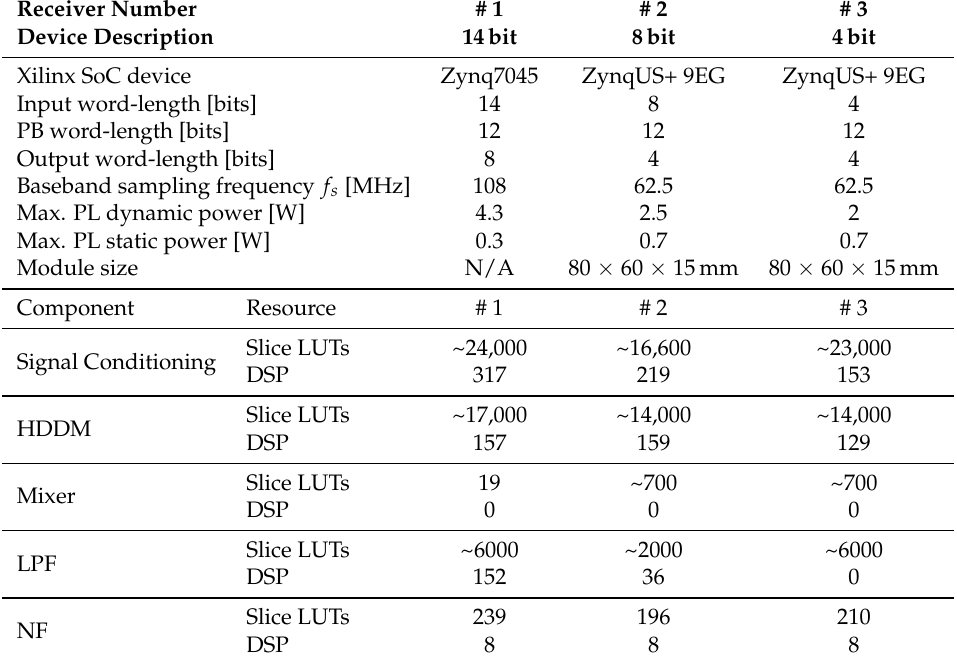
Table 1. Device properties and associated resource